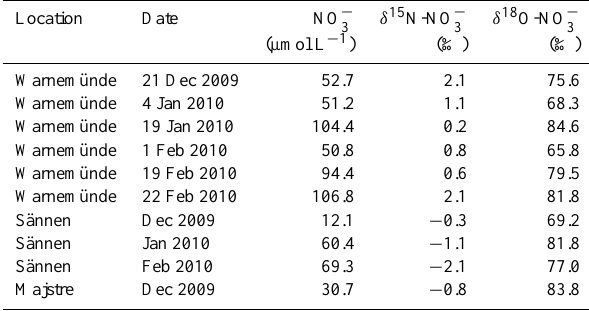
Table 1. NO − concentrations and δ 15 N-NO − 3 ues of wet atmospheric deposition. Data are from Warnemünde (Germany), Sännen (Sweden), and Majstre